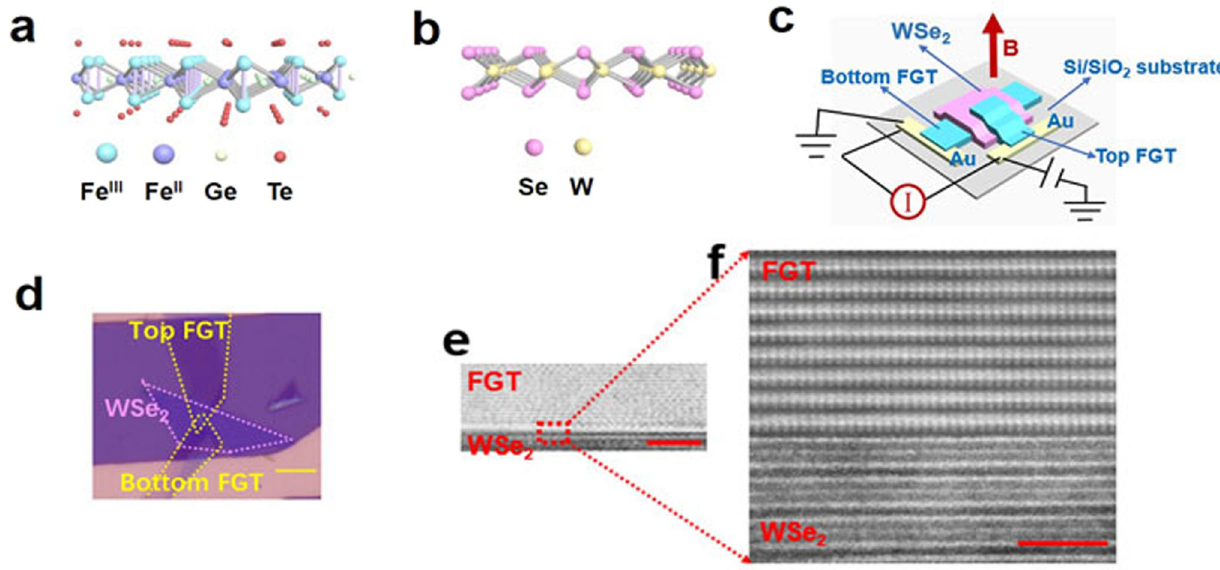
Fig. 1 Schematic of spin valve device built upon van der Waals heterostructures. a FGT crystal structure. b WSe 2 crystal structure. c Device structure of FGT/WSe 2 /FGT spin valve. d Optical image of the FGT/WSe 2 /FGT spin valve. Scale bar: 10 µm. e Scanning transmission electron microscope (STEM) of the FGT/WSe 2 interface. Scale bar: 10 nm. f The enlarged STEM image of the FGT/WSe 2 interface. Scale bar: 2